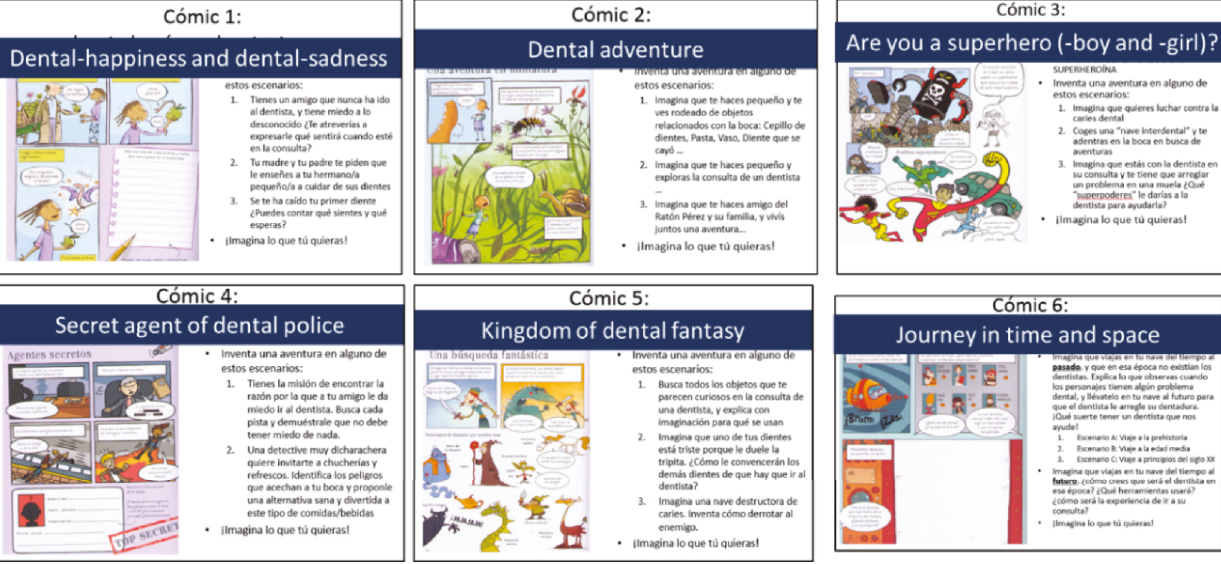
Figure 18: Examples of comic topics proposed to children to inspire them (extracted from